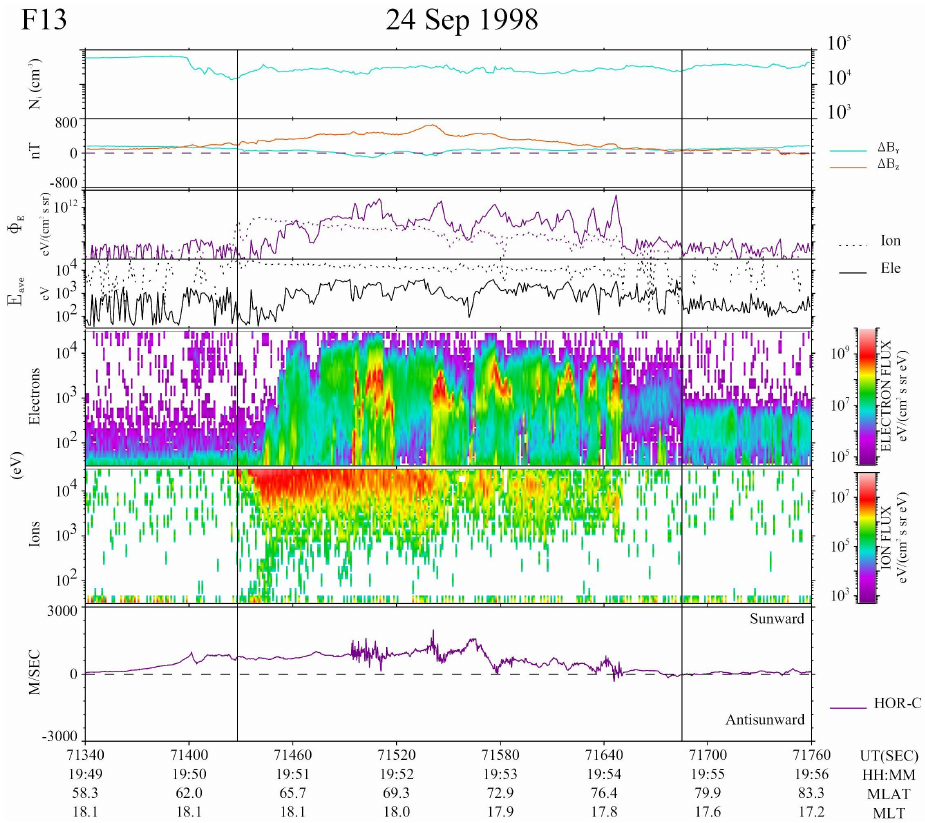
Fig. 10. Plasma measurements within the 19:49–19:56 UT interval on 24 September 1998 from the DMSP F13 pass over auroral latitudes. From top to bottom: ion density (first panel); variations of the magnetic field east-west ( B z , brown) and north-south ( B y , green) components (second panel); energy flows and mean energy of electrons and ions (third and fourth panels); energy spectrograms of electrons and ions (fifth and sixth panels); plasma drift velocity (seventh